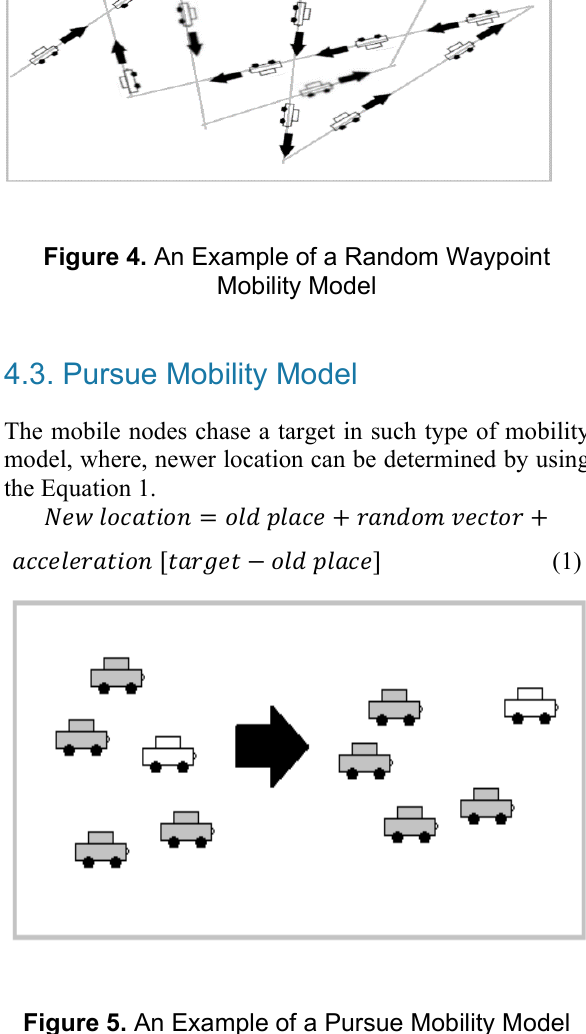
A random vector is a counterbalance for individually mobile node and acceleration, which is, how the mobile nodes are chasing the target, as shown in (Figure 5). The randomness degree of each node is confined to